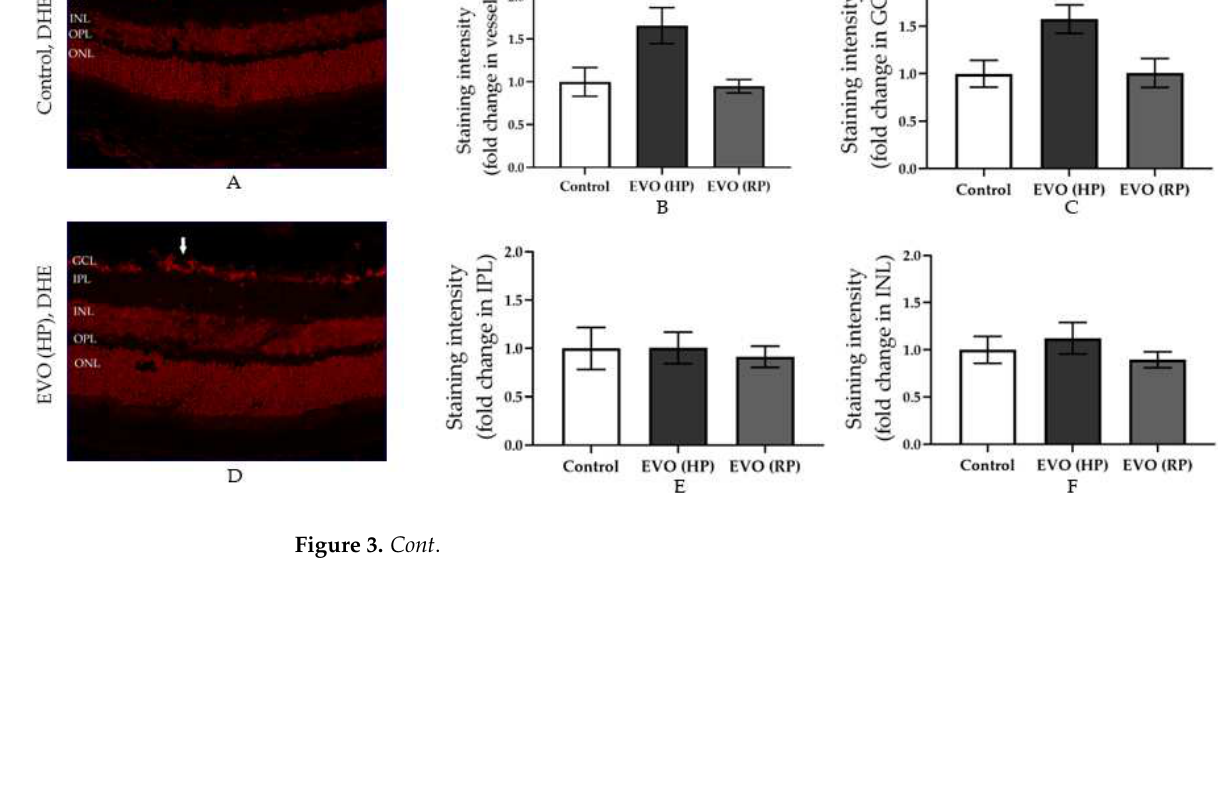
Figure 3. DHE-stained retinal cryosections and intensity quantification for individual retinal layers. ( A ), ( D ), and ( G ) show the DHE-stained retinal cryosections in the control, EVO (HP), and EVO (RP) groups, respectively. ( B ), ( C ), ( E ), ( F ), ( H ), and ( I ) show the staining intensity quantified from ves- sels, GCL, IPL, INL, OPL, and ONL, respectively. The white arrows point to retinal blood vessels. GCL: ganglion cell layer; IPL: inner plexiform layer; INL: inner nuclear layer; OPL: outer plexiform layer; ONL: outer nuclear layer. EVO: episcleral vein occlusion; HP: high intraocular pressure; RP: recovered intraocular pressure. Control group refers to sham group. Values are expressed as mean ± SEM (* p < 0.05; n = 5–6 per group, scale bar = 50 μm). 3.4. Elevated IOP Reversibly Increased the Expression of NOX2 in the Retina The immunoreactivity of NOX2 was increased in retinal vessels and the ganglion cell layer in the EVO (HP) group (Figure 4C–F). However, this overexpression of NOX2 nor- malized four weeks after IOP normalization, as is shown in the staining of the EVO (RP) group (Figure 4C,D,I,J).